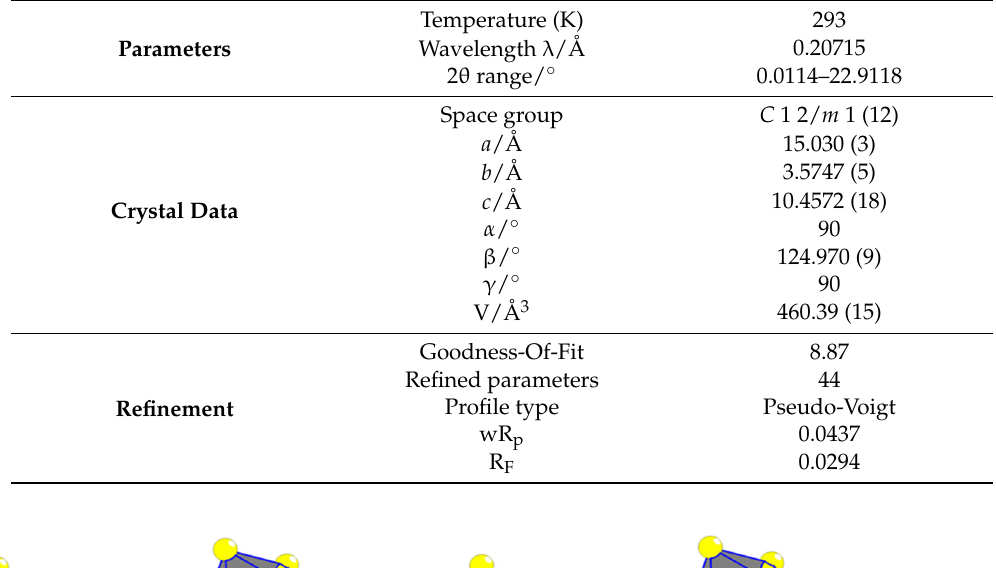
Table 1. Crystal structure data for Ca 1 − x Ir 4 S 6 (S 2 ) obtained from JANA2006 refinement. The refined